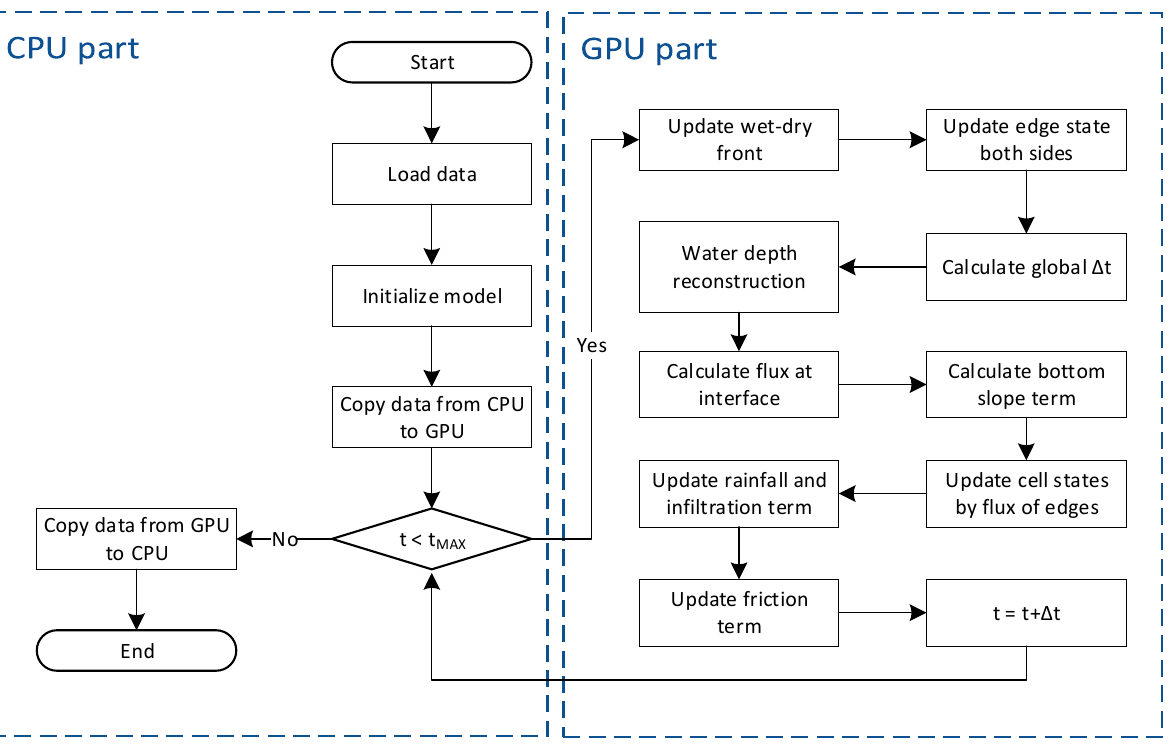
Figure 3. Multi-thread hydrodynamic numerical simulation process in